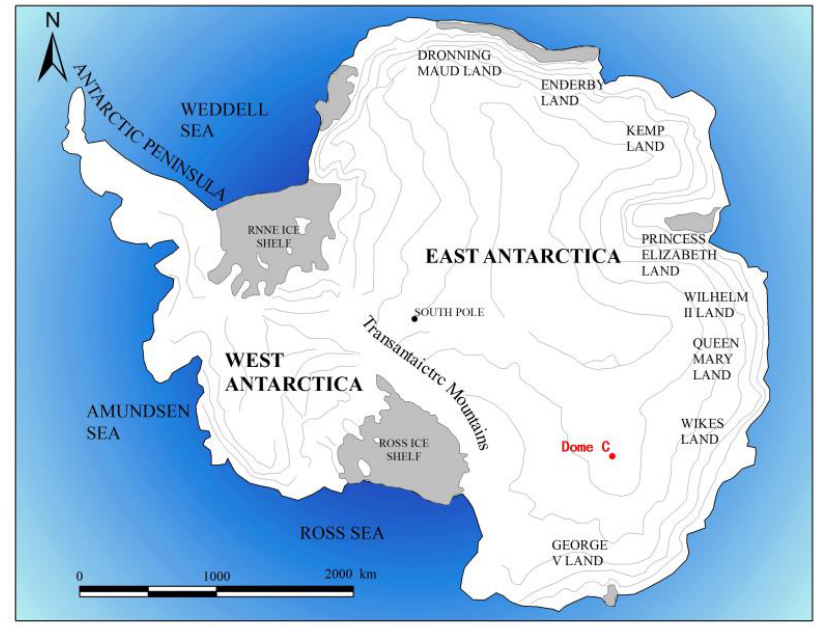
Figure 2. Geographical location of the calibration